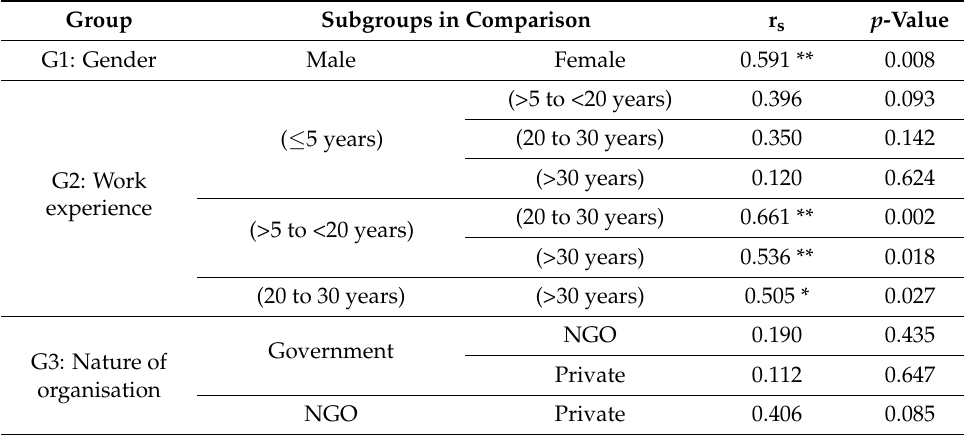
Table 3. Spearman rank correlations between